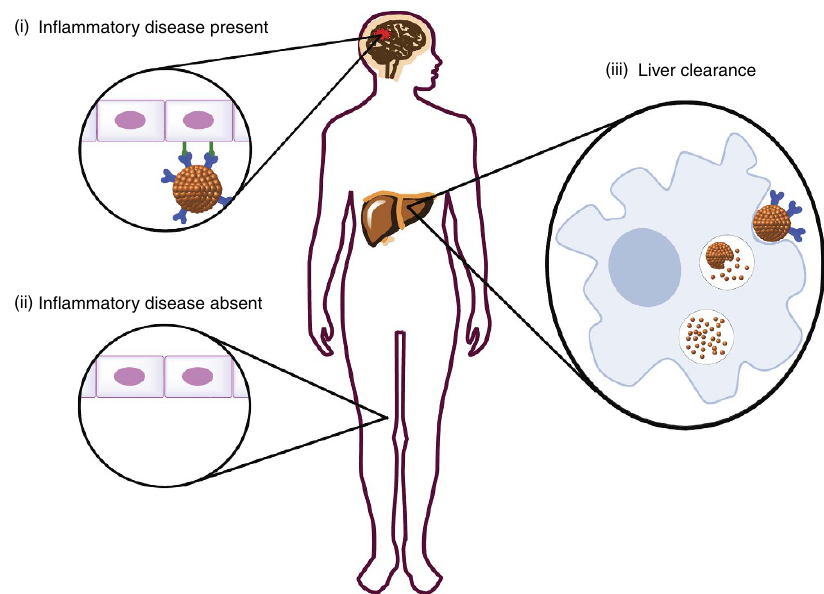
Figure 1 | Molecular basis of mMPIO as a targeted MRI contrast agent. Intravenously injected targeted mMPIO bind to their target on the diseased endothelial surface (i), but do not bind to healthy endothelium (ii). The unbound mMPIO are rapidly cleared from blood. Thus, negligible background contrast effects are evident with mMPIO shortly after injection. mMPIO are efficiently taken up by macrophages (iii), and after internalization and fusion to lysosomes the internal peptide linkers are degraded. mMPIO are represented as brown sphere conglomerates, iron oxide nanoparticles are represented as brown spheres, targeting agents are represented in dark blue and endothelial surface disease markers are shown in green.